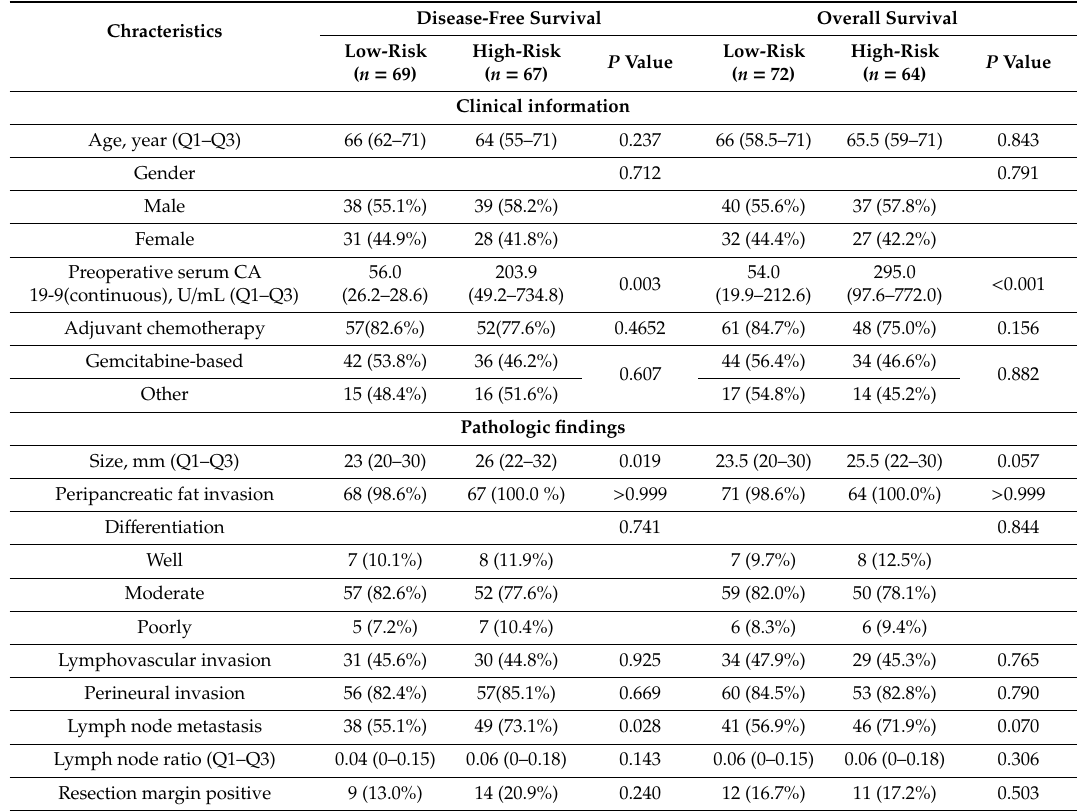
Table 3. Clinical and pathologic characteristics of proposed nomogram-based risk groups. CA 19-9, carbohydrate antigen 19-9; CT, computed tomography; AJCC, American Joint Committee on Cancer. Disease-Free Chracteristics